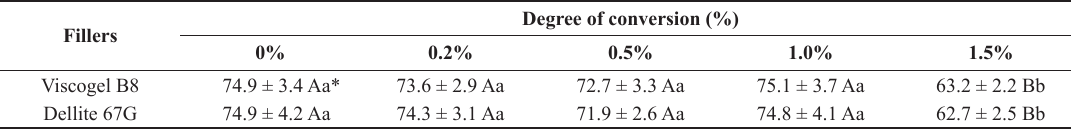
Table 2. Mean and standard deviation of conversion degree (%) of dental adhesives